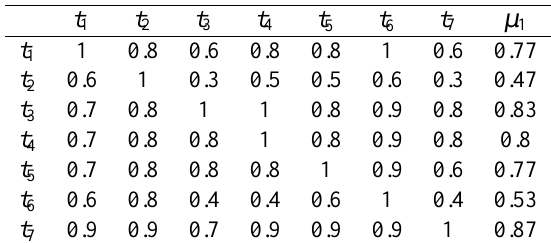
Table 7. Outranking degrees (Example